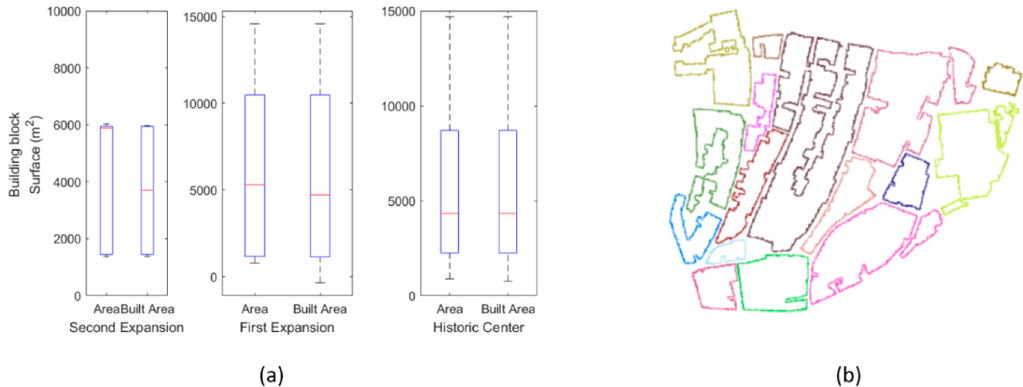
Figure 9. ( a ) Comparison of building block surface and built surface for the three case study areas. ( b ) Although individual buildings are smaller in the city centre, in many cases they are built without physical separation, hence they are considered the same building block, having an impact on the interpretation of the results.